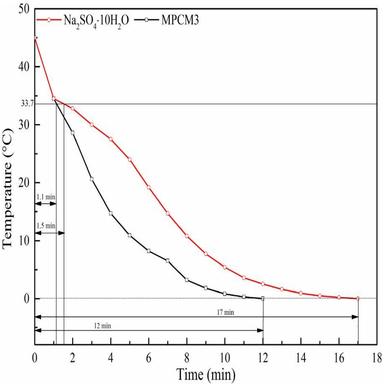
The temperature curves of the Na2SO4·10H2O and MPCM3 in solidifying process.